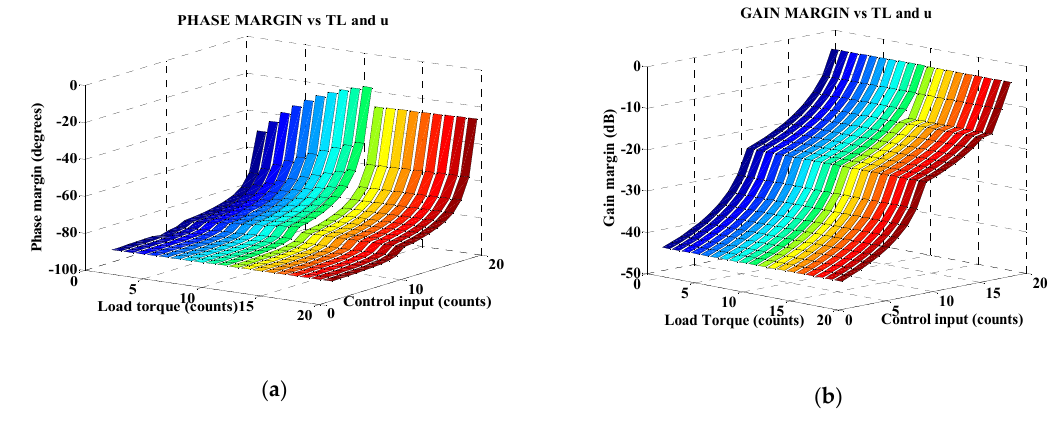
Figure 9. Margin plots for ω ( s ) vs. i(s); ( a ) Phase margin; ( b ) Gain margin.